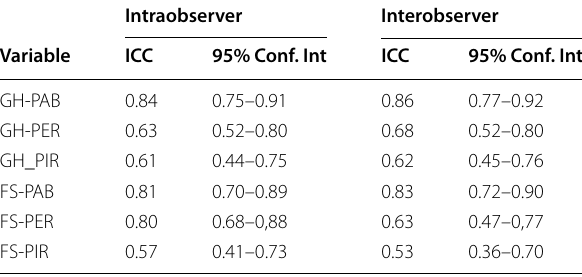
and interobserver Intraclass Correlation Coefficients (ICC) with 95% confidence intervals (95% Conf.